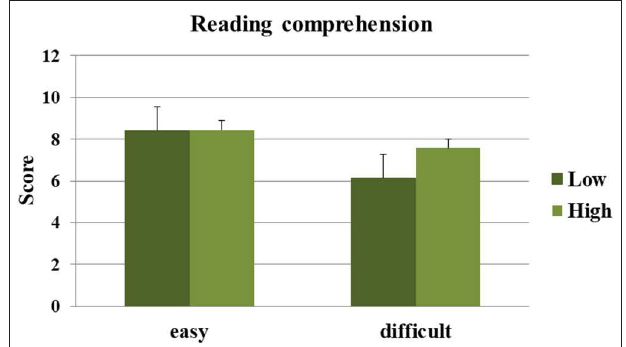
FIGURE 4 | Mean score of reading comprehension between text difficulty conditions for low and high WMC